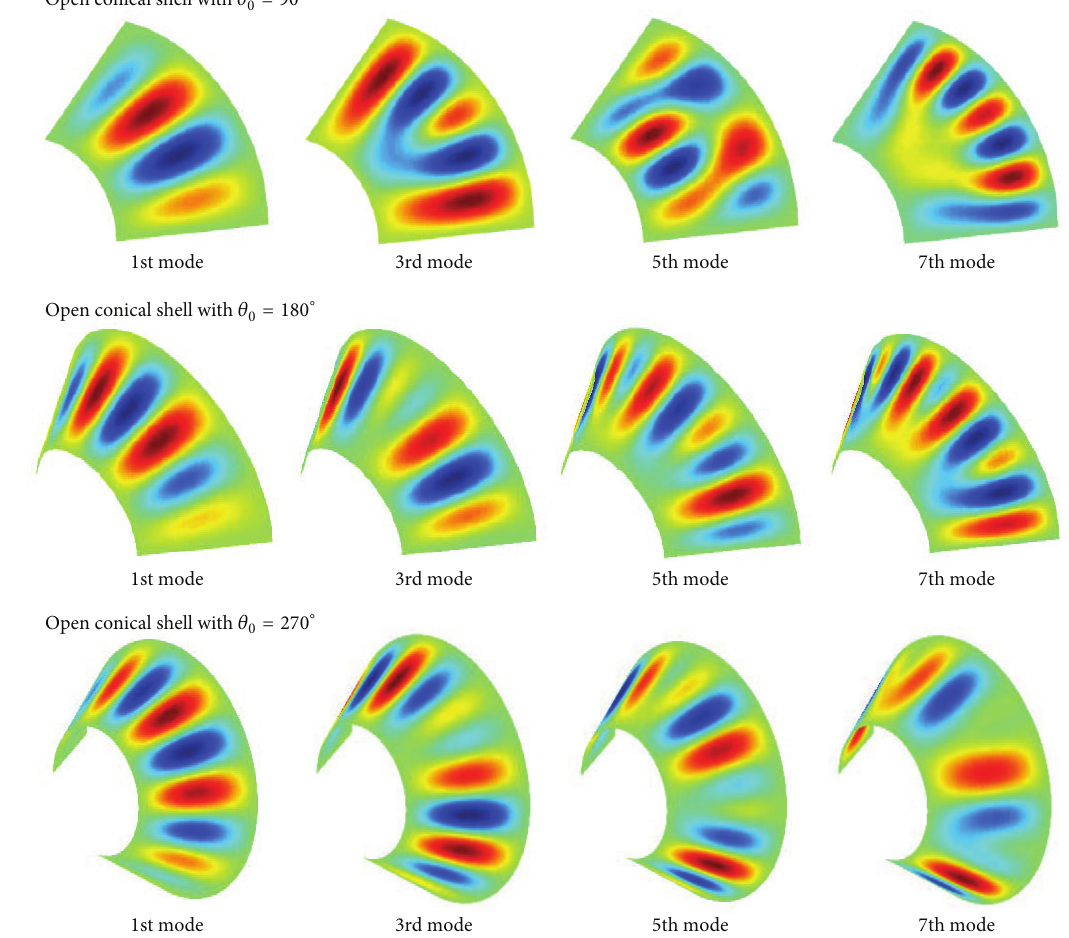
Figure 7: Some selected mode shapes for an open conical shell with E 3 -C-E 3 -C boundary